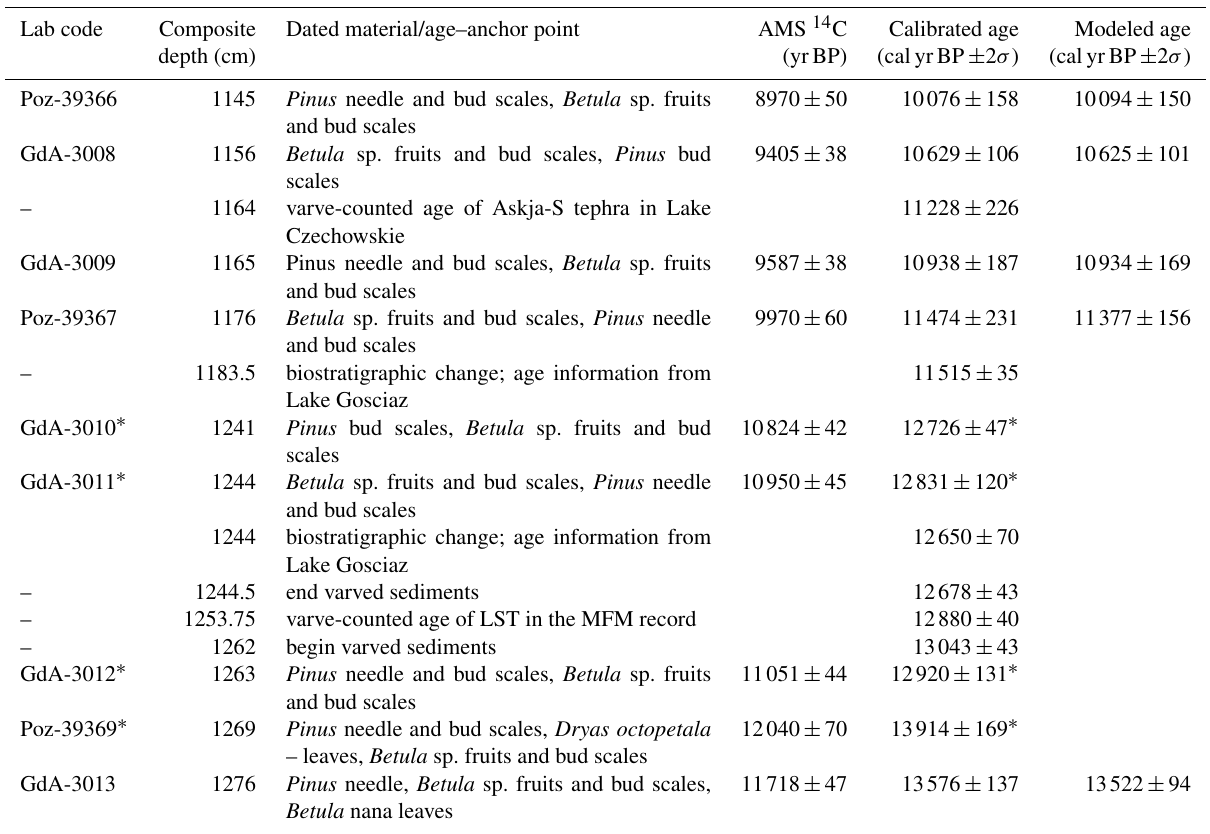
Table 1. Age–anchor points used for age–depth calibration of the studied core section (Słowinski et al., 2017). LST: Laacher See Tephra. Age from Brauer et al. (1999a). Askja-S age from Ott et al. (2016). Biostratigraphic age at the YD–Holocene transition from Ralska-Jasiewiczowa et al. (1992) and Litt et al. (2001). Age–depth plot of the age model in Fig. S1 in the